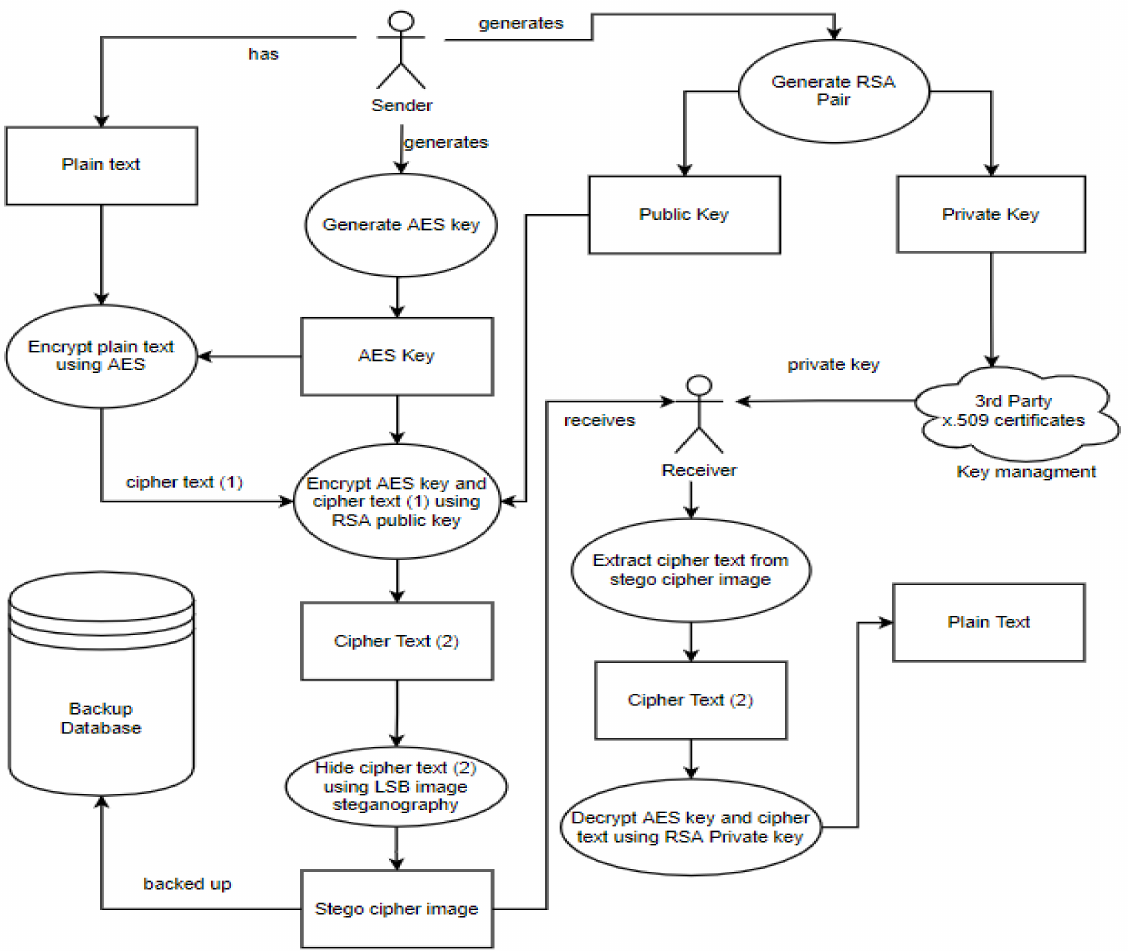
Figure 3. A description of the data backup step of the security